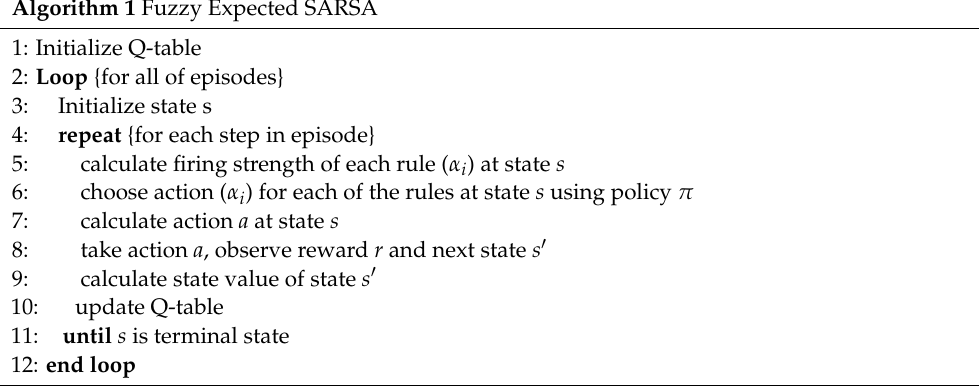
Algorithm 1 Fuzzy Expected